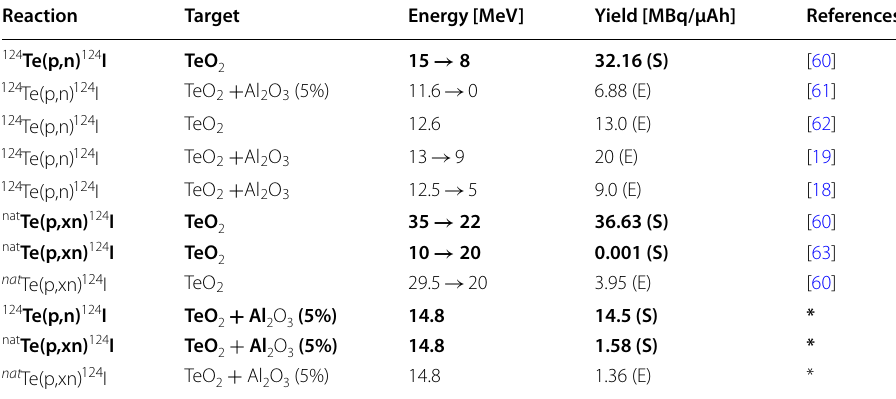
*This work, S, simulation; E, experiment